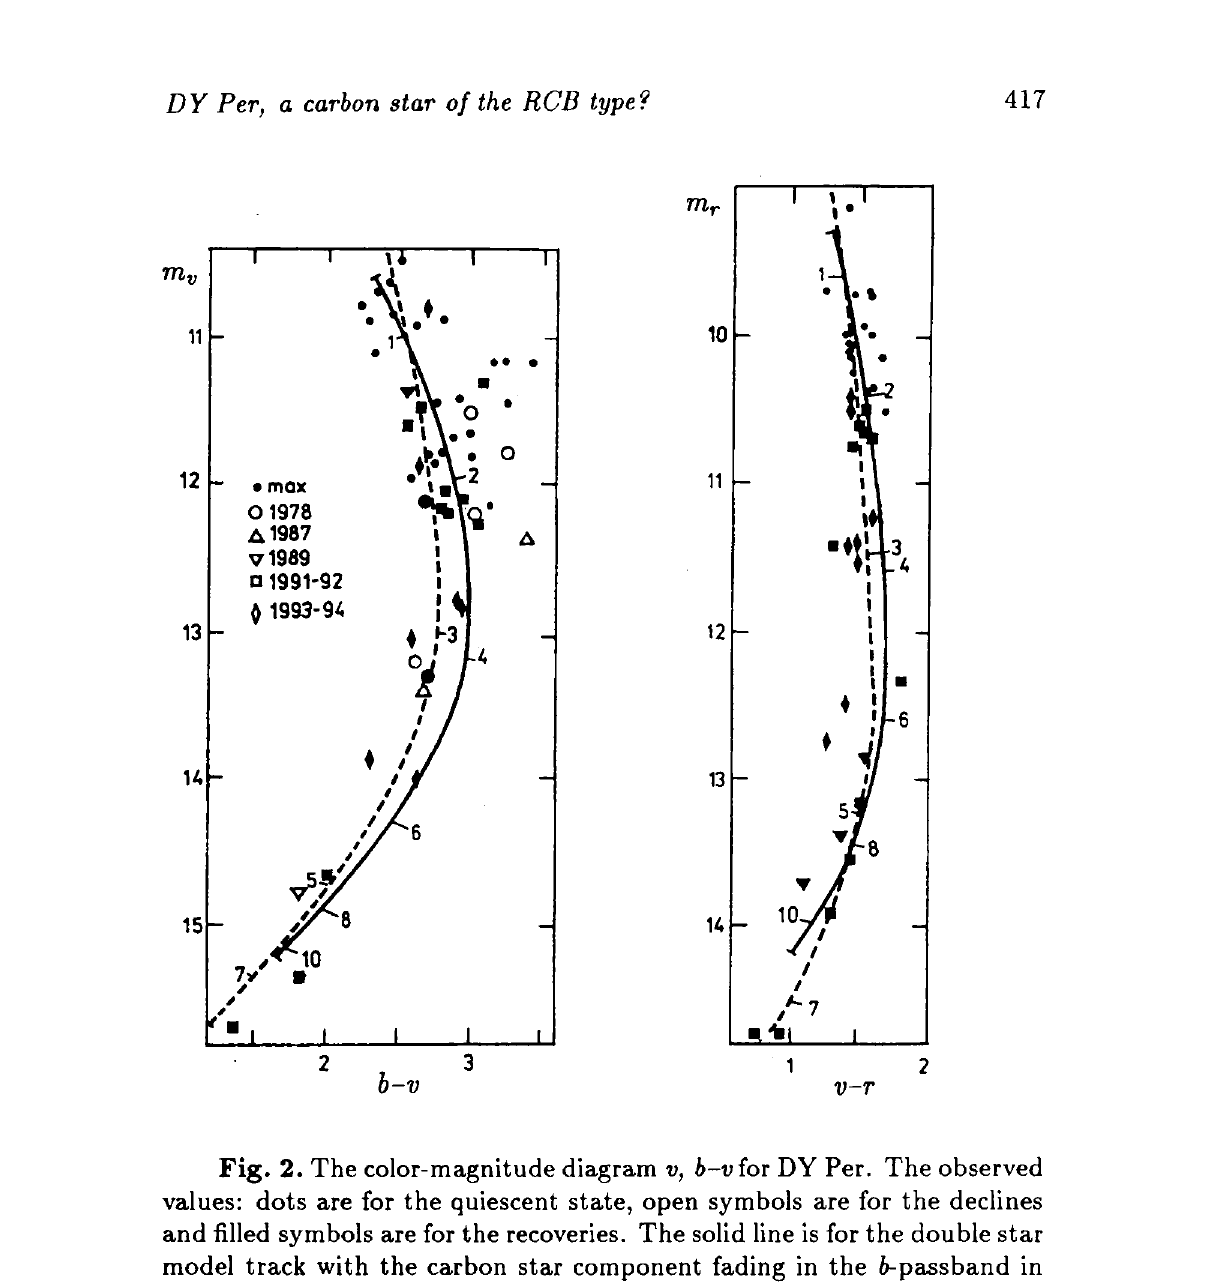
Fig. 2. The color-magnitude diagram v, b-νίοτ DY Per. The observed values: dots are for the quiescent state, open symbols are for the declines and filled symbols are for the recoveries. The solid line is for the double star model track with the carbon star component fading in the 6-passband in the magnitudes marked (even numbers); the dashed line is for the Grinin's simple model for s v = 0.005 with the optical depth of the obscuring dust cloud τ υ marked (odd numbers). Fig. 3. The color-magnitude diagram r, v-r for DY Per. The symbols are the same as in Fig.